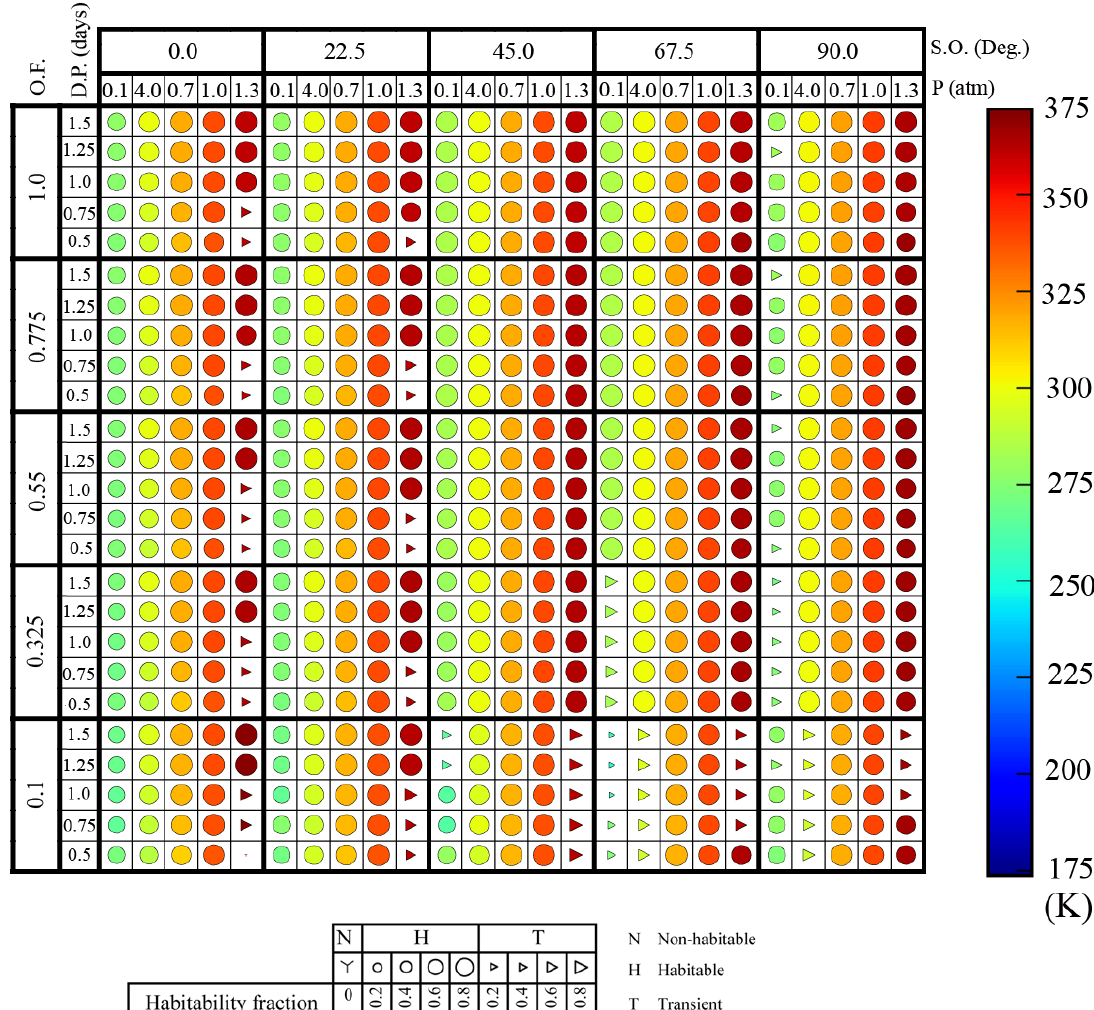
240 | M. Bahraminasr et al. , Effect of four unknown parameters included in a latitudinal energy balance model mean temperature above 350 K (Spiegel et al. 2008; Koppa- rapu et al. 2013).